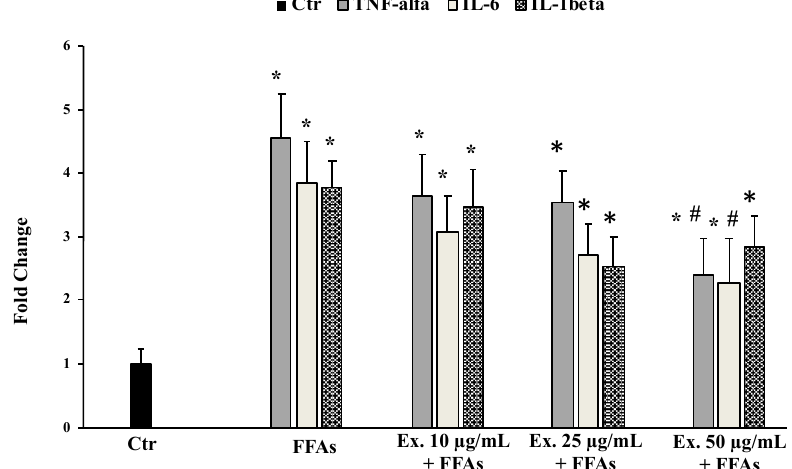
Figure 7. Effects of Cynara sylvestris extract pretreatment (10–25–50 µg/mL) for 24 h on mRNA expression levels of oxidative-stress-related genes: TNF-alfa, IL-6, and IL-1 beta. The data are reported as the mean ± S.D. of three independent experiments in triplicate. * Significant vs. untreated control cells p < 0.001. # Significant vs. FFAs, p <